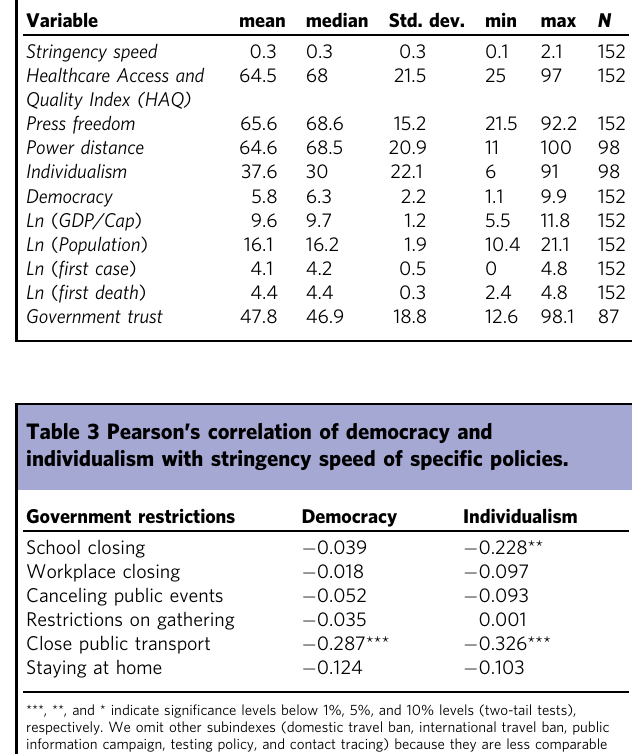
Table 2 Summary statistics.